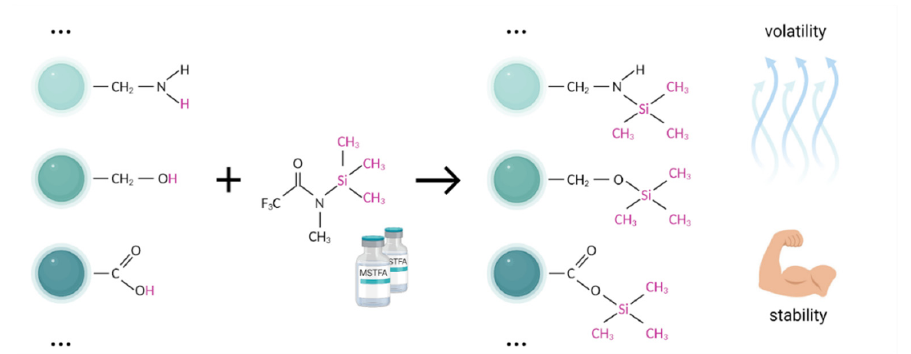
Figure 4. The typical scheme of trimethylsilylation. Bimolecular nucleophilic substitution (SN2) re ‐ places the active hydrogen ( ‐ OH, ‐ COOH, ‐ NH, ‐ NH2, and ‐ SH) by the trimethylsilyl group. Com ‐ pared to the initial compounds, silylated derivatives generally are more volatile and thermally sta ‐ ble, thus yielding advanced separation of symmetric and narrow chromatographic